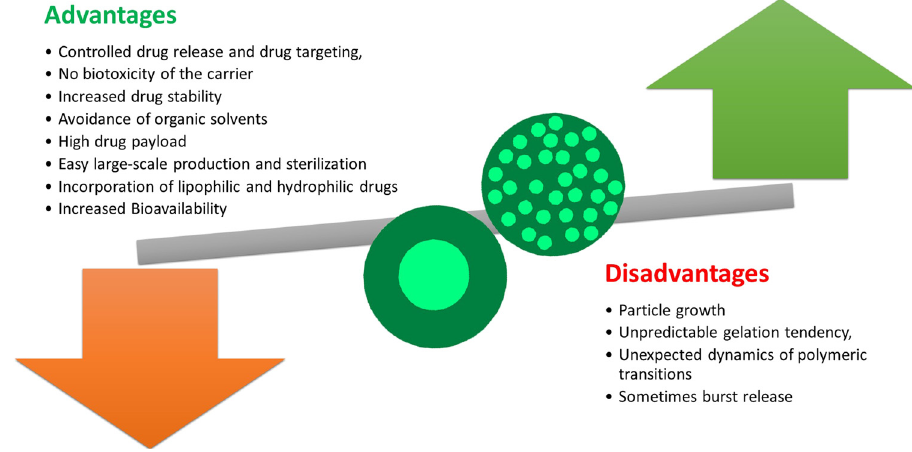
Figure 5: Advantages and disadvantages of